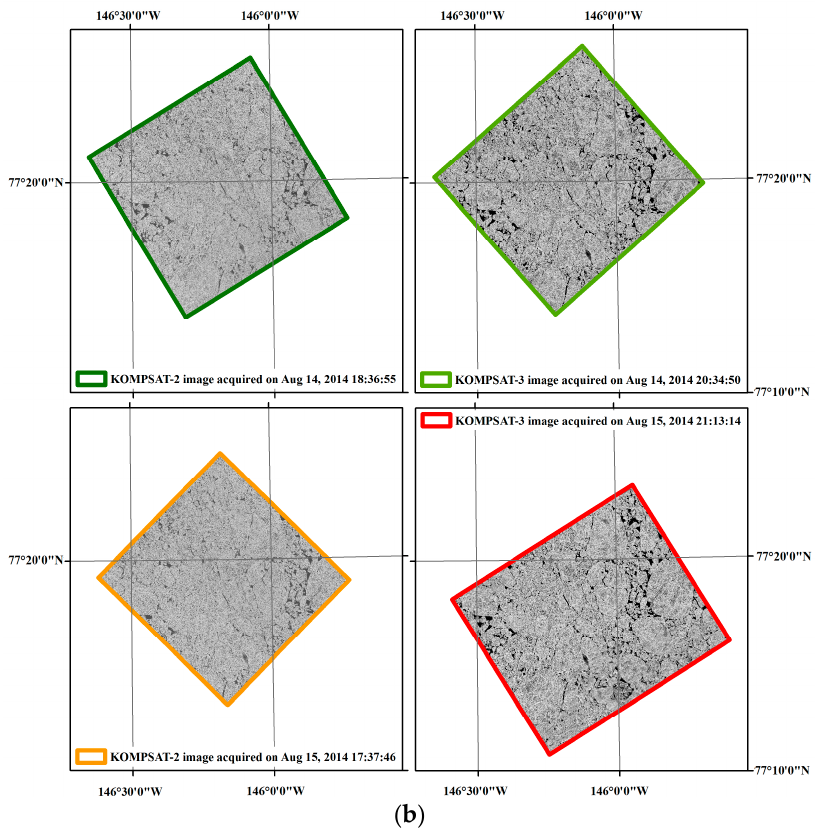
Figure 2. Sea ice condition in the study area: ( a ) the sea ice concentration (SIC) around the study area retrieved from the daily SIC data of the National Snow and Ice Data Center (NSIDC) from Nimbus-7 SMMR and DMSP SSM/I-SSMIS Passive Microwave Data [29] on 14 August 2014; and ( b ) an overview of sea ice coverage captured in each satellite image.